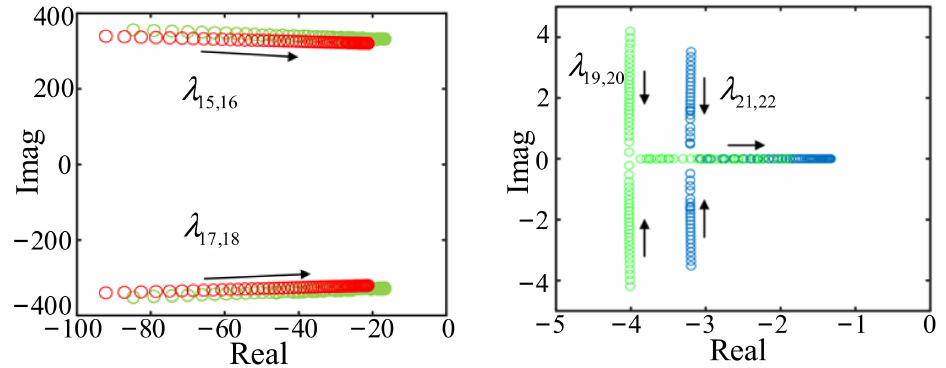
Figure 12. Eigenvalue trajectories of the system under different line resistances.